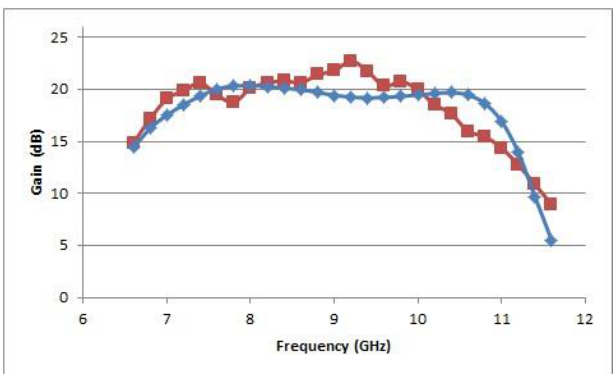
Figure 12: Power gain for amplifier operating between 8- 10 GHz. Blue line: simulation, red line: measurement